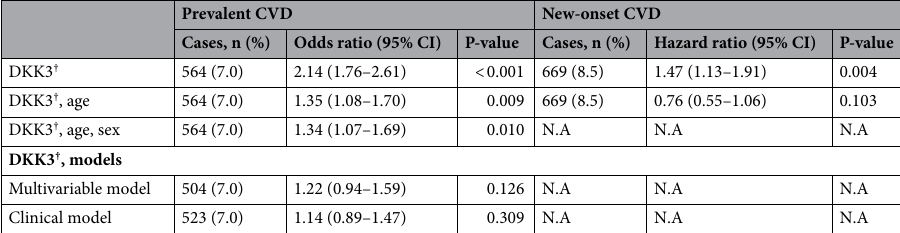
Table 4. DKK3: Prevalent and new-onset CVD. CI Confidence Interval. CVD Cardiovascular disease. DKK3 Dickkopf-3. Multivariable model as presented in Table 3. Clinical model includes age, sex, body mass index, systolic blood pressure, glucose † , cholesterol and estimated glomerular filtration rate † . Prevalent CVD: N = 8073 for DKK3 crude and age-adjusted, N = 7250 for DKK3 + multivariable model, N = 7480 DKK3 + clinical model. For new-onset CVD: N = 7828. †